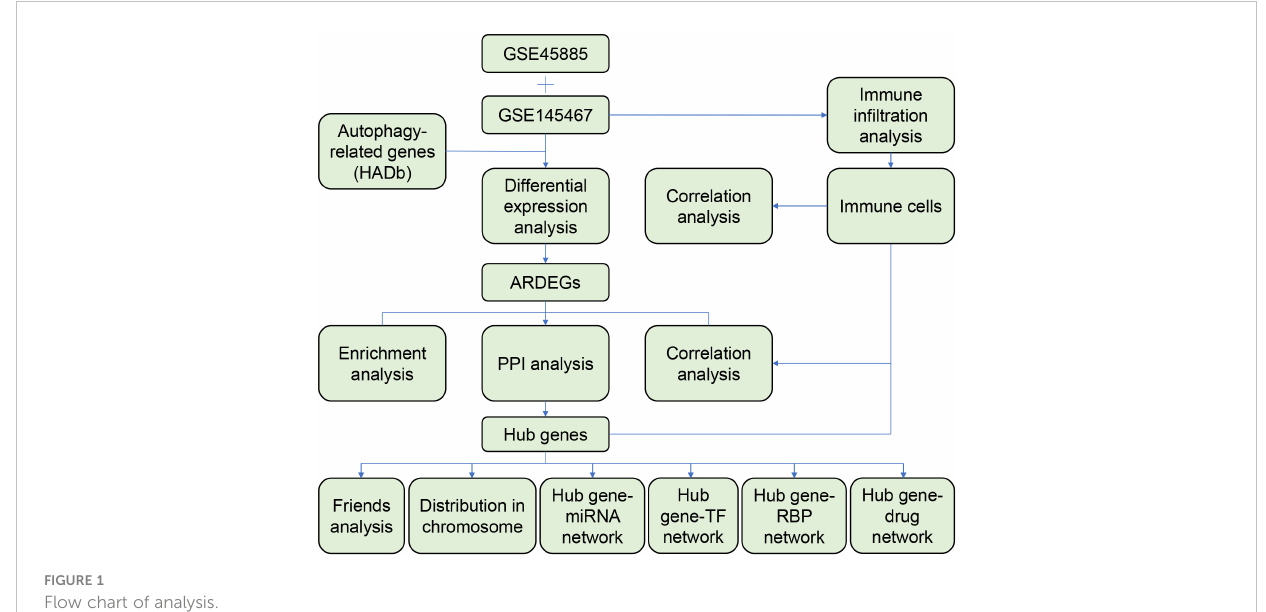
FIGURE 1 Flow chart of analysis.